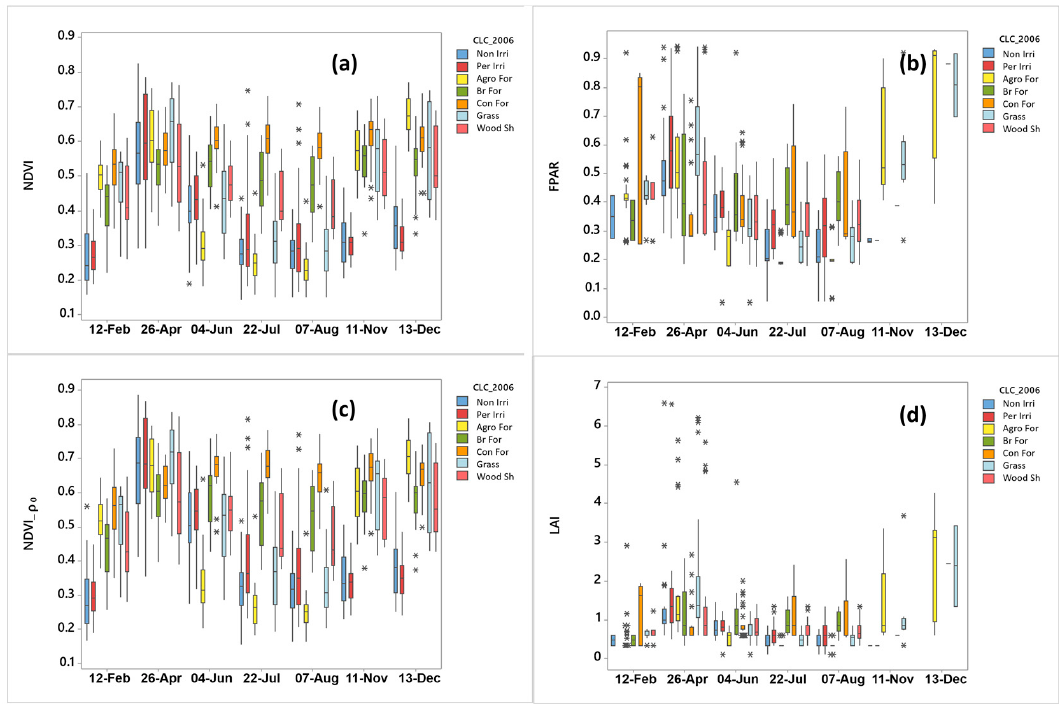
Figure 3. Normalized Difference Vegetation Index (NDVI) and NDVI constructed using the ρ 0 parameter instead of the Bidirectional Reflectance Factor (BRF) reflectance, Leaf Area Index (LAI), and Fraction of Photosynthetically Active Radiation (FPAR) box plot shown with the CLC 2006 and MISR orbits captured on different dates in 2006. Outliers are identified by asterisks (*). ( a ) NDVI box plot; ( b ) FPAR box plot; ( c ) NDVI ρ 0 parameter box plot; and ( d ) LAI box plot.